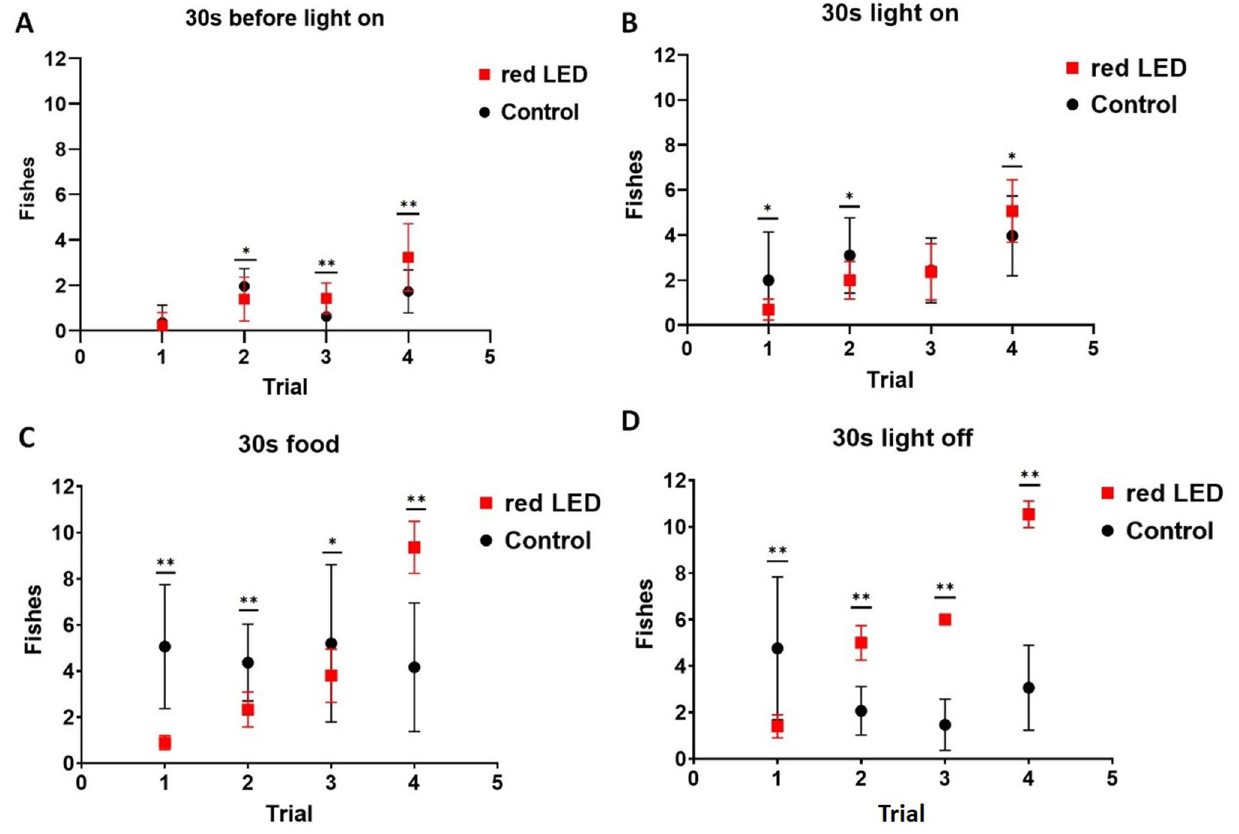
Figure 2. Zebrafish simple appetite conditioning responses using one stimulus: Red LED light. ( A ) Number of fish that were in the eating behavior before the light was turned on, ( B ) while the light was on, ( C ) during the feeding period and ( D ) after the stimulus is turned off. The horizontal lines of each group denote the mean ± SD and the asterisks on the brackets indicate statistical difference in comparison to the frequency of fish between the attempt and the control group by Mann–Whitney U-test (* p < 0.05; * * p < 0.001, *** p <